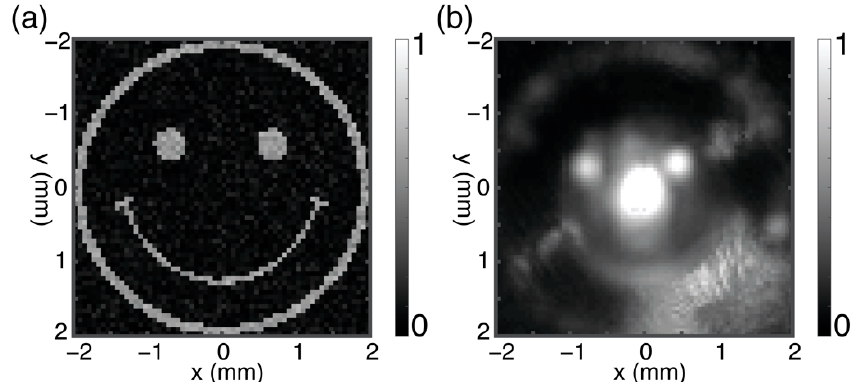
Figure 4. ( a ) Simulation results of the image after light illuminated the hologram. ( b ) Experimental results of the hologram image by using the on-axis optical setup. Note the presence of the zero order in the center of the image due to imperfect phase control.